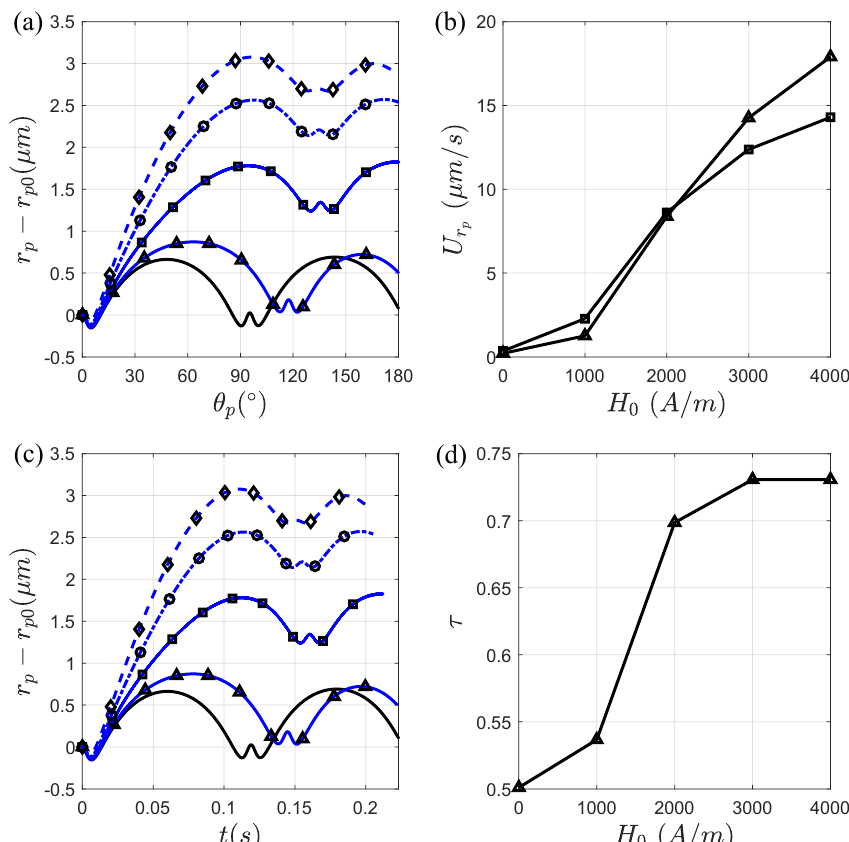
Figure A2. Effect of the magnetic field strength when it is applied at α = 90 ◦ on an elliptical particle ( AR = 4) that is in the upper curve of the channel. The particle is affected by the magnetic field when its center of mass is approximately at θ p = 0. The radial particle-wall distance change of the particle with respect to ( a ) θ p , and ( c ) time for, H 0 = 0 A/m (solid black line), H 0 = 1000 A/m (triangle symbol), H 0 = 2000 A/m (square symbol), H 0 = 3000 A/m (circular symbol), H 0 = 4000 A/m (diamond symbol). ( b ) The radial velocities U rp (triangle symbol) and U r θ (square symbol) are functions of H 0